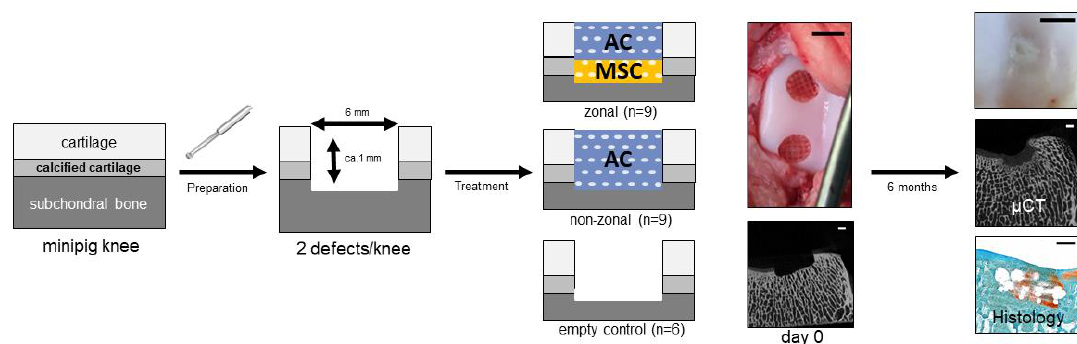
Figure 7. Study design. A full thickness defect was prepared in native cartilage in minipigs in vivo and treated with a zonal and a non-zonal starPEG construct containing PCL with articular chondrocytes (AC) in the top layer and MSC in the bottom layer or only AC, respectively. The outcome was compared to an empty control after 6 months of treatment via macroscopy, µ CT analysis and histology. scale bar µ CT images and histology: 1 mm; scale bar macroscopic images 6 mm.